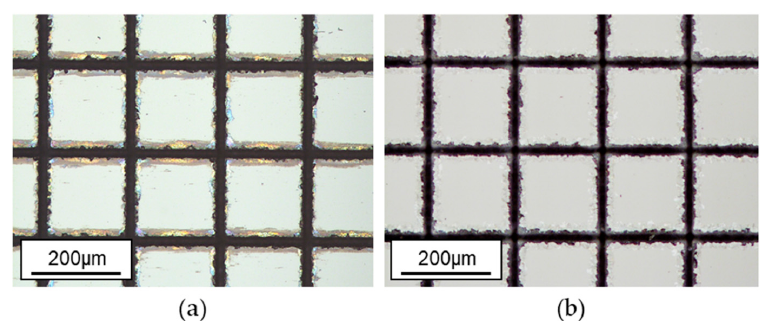
Figure 9. Optical microscope image of the laser-generated structure: ( a ) before and ( b ) after the cleaning in 5% hydrogen fluoride (HF) solution. The glass sample was etched for 2 min. Figure 8c,d show the same microfluidic device before and after the laser microwelding process. Optical fringes visible in Figure 8c indicate a large gap between the two glass plates. Two adjacent bright or dark fringes represents a change in the gap length by λ /2.